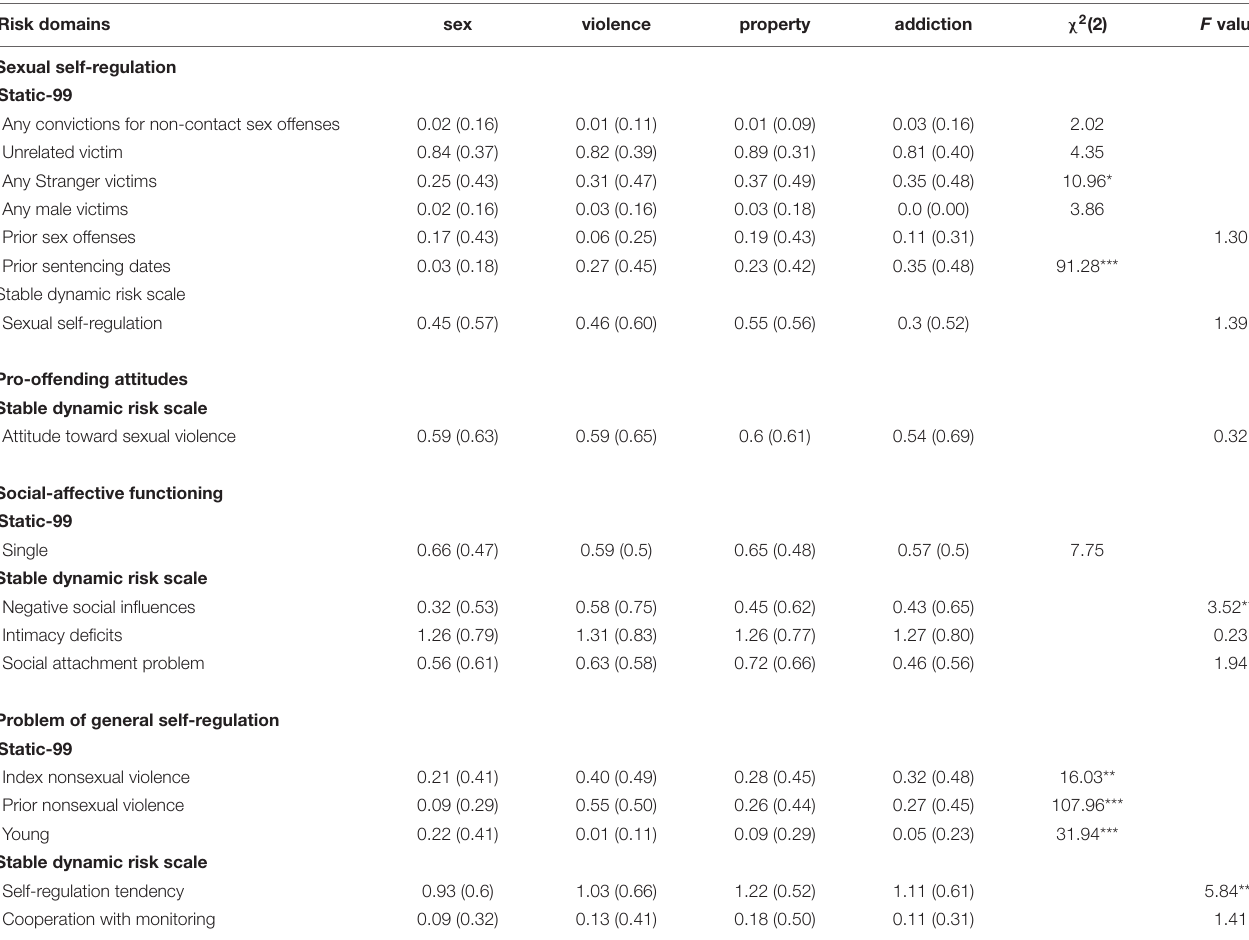
TABLE 4 | Onset-group comparison with four risk domains (psychological